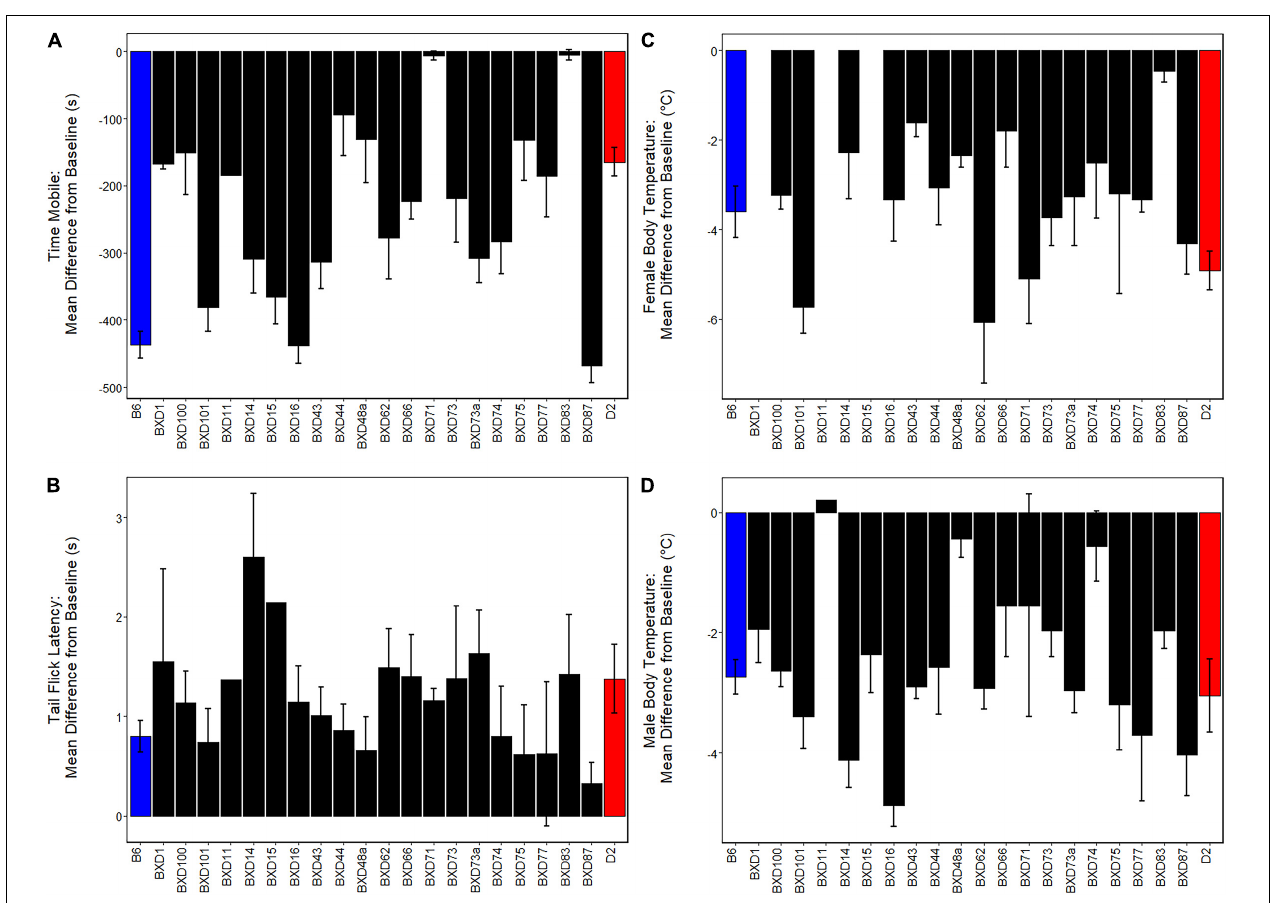
FIGURE 2 | Variation in Initial Response to THC Among BXDs. A significant effect of THC treatment relative to baseline ( p < 0.001) was observed for all traits. Initial response to THC is shown as the difference between baseline and initial THC treatment. Strains are shown on the x -axis and initial response (difference between baseline response on day 0 and response to THC on day 1) is shown on the y -axis. Negative values indicate a decrease in response on day 1 compared to day 0 and positive values indicate an increase in response. Parental strains are indicated in blue (B6) and red (D2) and BXD strains are shown in black. (A) There is a significant effect of strain ( p < 0.001) on initial response to THC for time spent mobile in the open field 30 min post-injection. Male and female responses were combined as there were no significant interaction effects involving sex. Responses to THC varied ∼ 90-fold among strains for the mobility trait. (B) The antinociceptive effects of THC were quantified using tail withdrawal latency in response to a thermal stimulus at 60 min post-injection. Male and female responses were combined as there were no significant interaction effects involving sex. Response to THC varied nearly 8-fold across strains, however, no significant effects of strain were observed for the antinociception trait. (C,D) There is a significant main effect of strain ( p < 0.05) on initial hypothermic response 60 min post-injection of THC for both females (C) and males (D) . Hypothermic response to THC in females varies 13-fold across strains compared to 24-fold variation in response in males. Summarized B6 and D2 responses shown for comparison (Parks et al.,